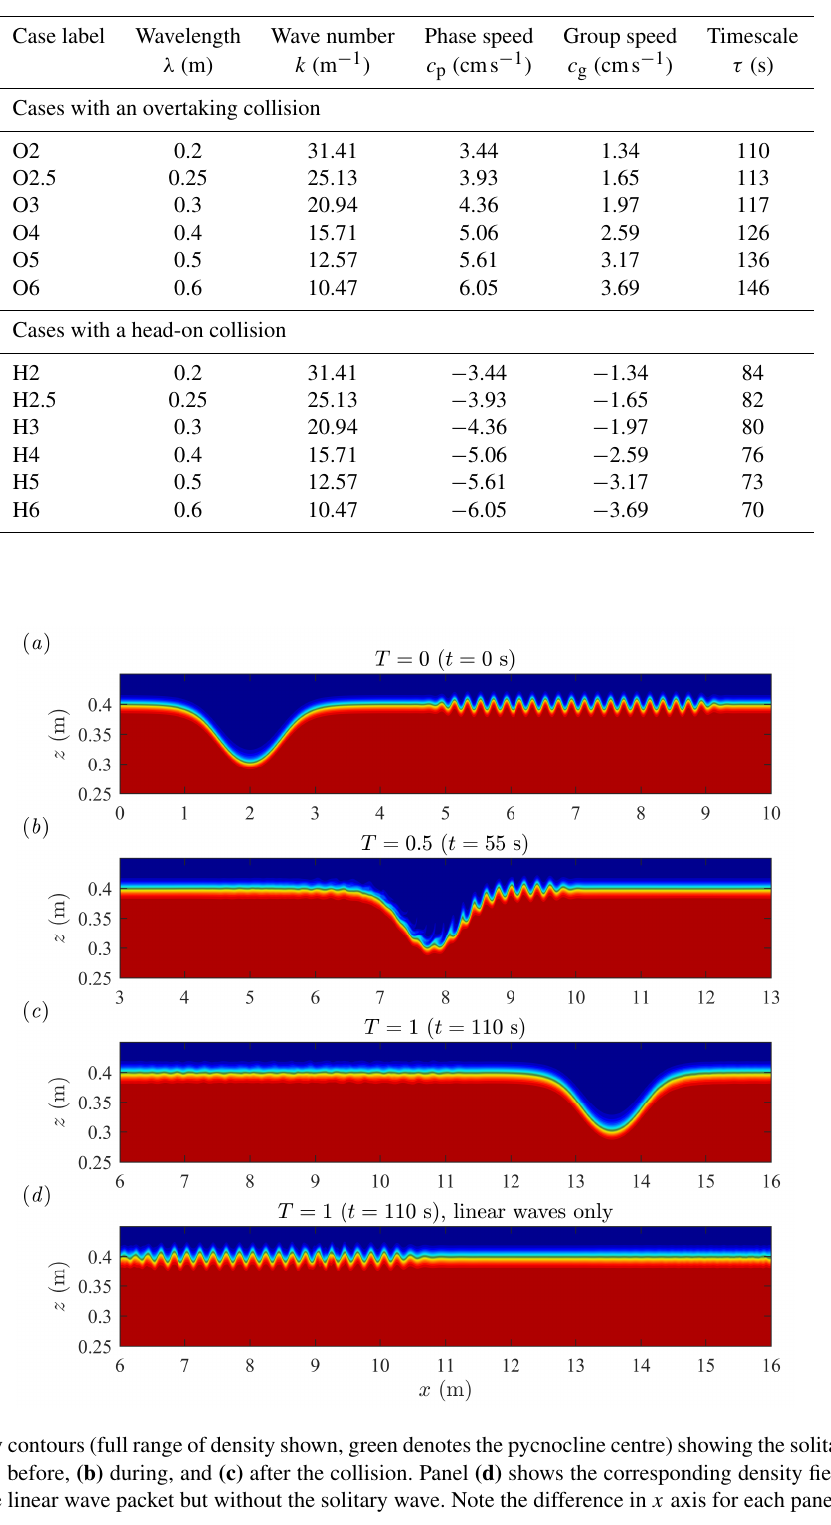
Table 2. Linear wave parameters. In the case labels, O indicates an “overtaking” collision and H indicates a “head-on” collision, and the proceeding digits correspond to the wavelength of the linear waves.